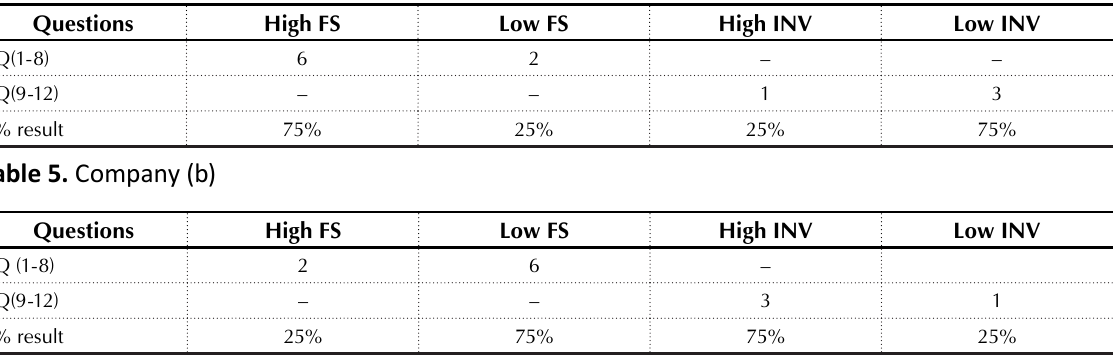
Table 4. Company (a)